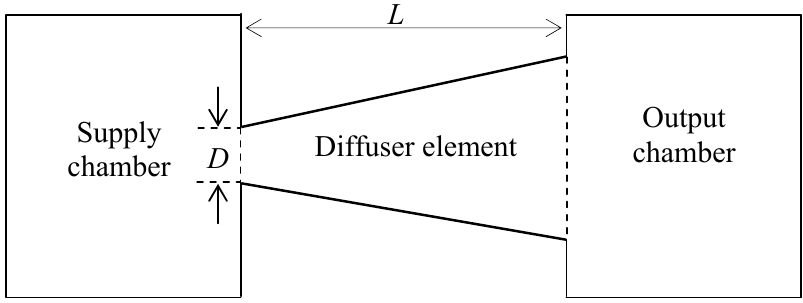
Figure 3. Simplified model of the valveless micropump.